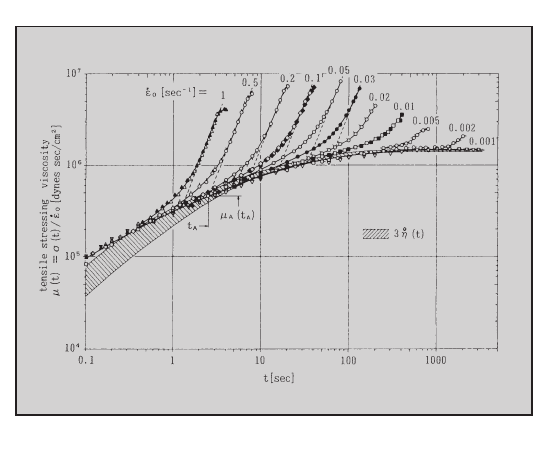
Figure 10 : Extensional stresses viscosity, µ (t), and comparison with the (linear-viscoelastic) shear stressing viscosity, η (t) (Melt, I, T=150°C, ε 0 = constant extensional strain